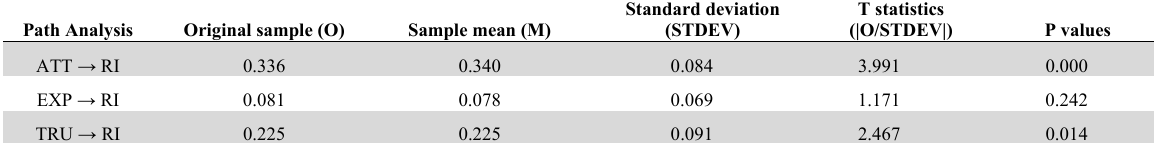
Total Indirect Effects Path